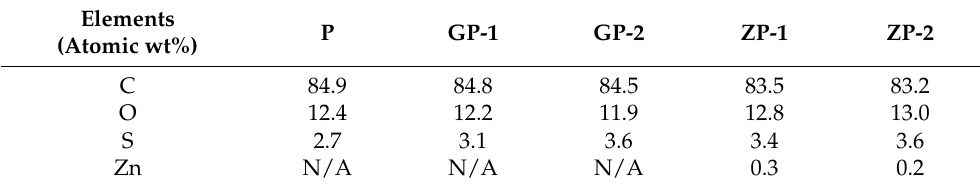
Table 3. Element composition of fabricated membranes obtained from XPS data.